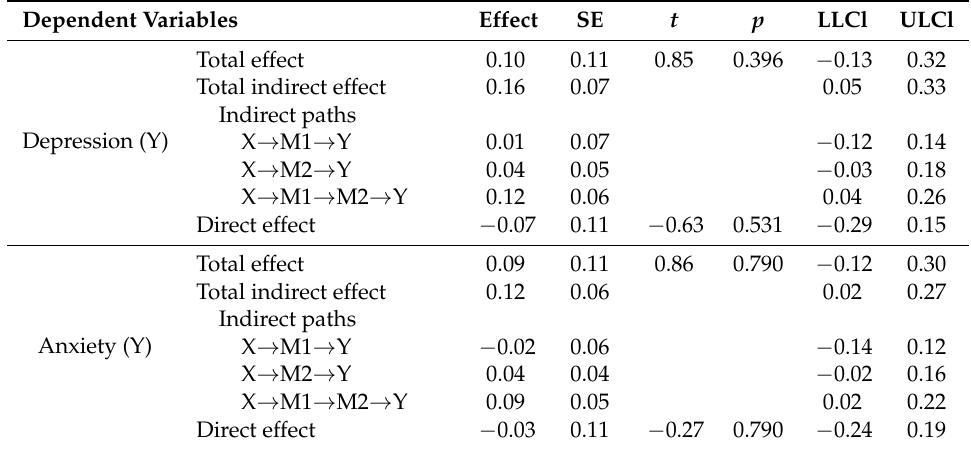
Table 3. Sequential mediation effect of anger suppression and anger rumination in the relationship between emotional labor and depression/anxiety.